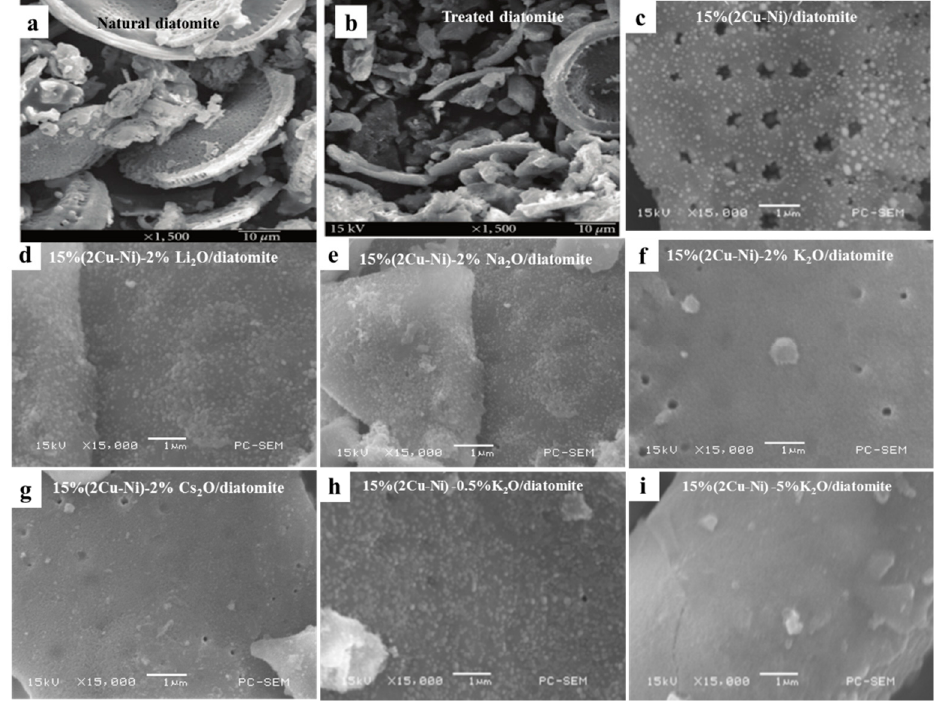
Figure 5. Scanning electron micrographic images of the samples.